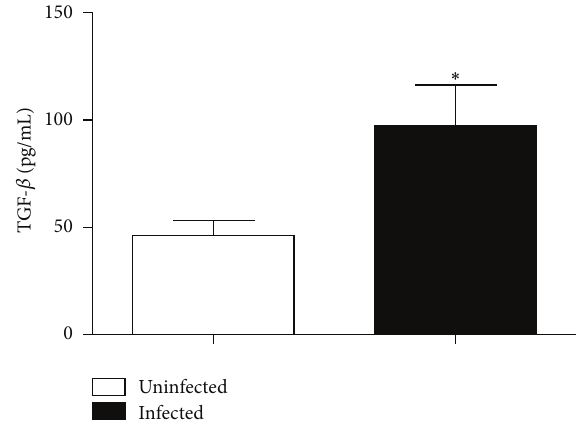
Figure 3: Peritoneal TGF- 𝛽 1 levels in uninfected (white) and S. mansoni -infected mice (black). Data were expressed as mean and SEM. 𝑛 = 6 (uninfected) or 4 (infected) mice. ∗ 𝑃 < 0.05 (Student’s 𝑡 -test).